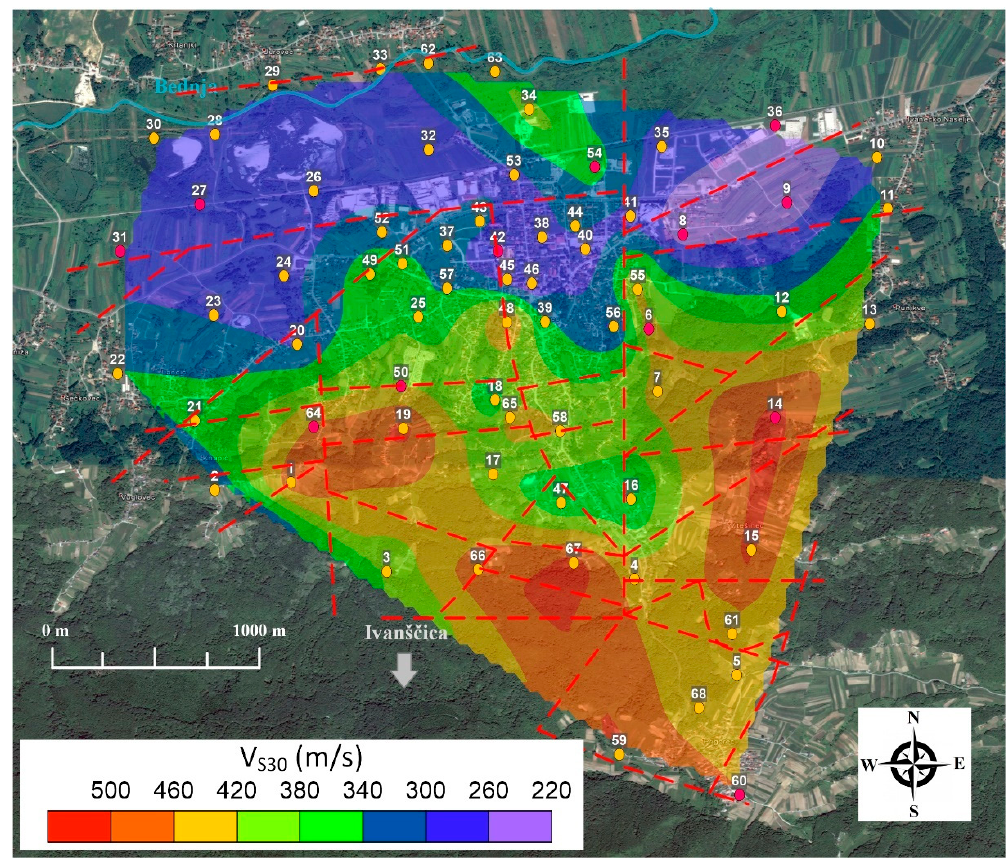
Figure 11. Map of V S30 distribution for the City of Ivanec. Red circles indicate location of geophysical measurements and yellow microtremor measurements. According to Eurocode 8 soil classification [30], city area can be divided into soil classes B (360–800 m/s) and C (180–360 m/s).